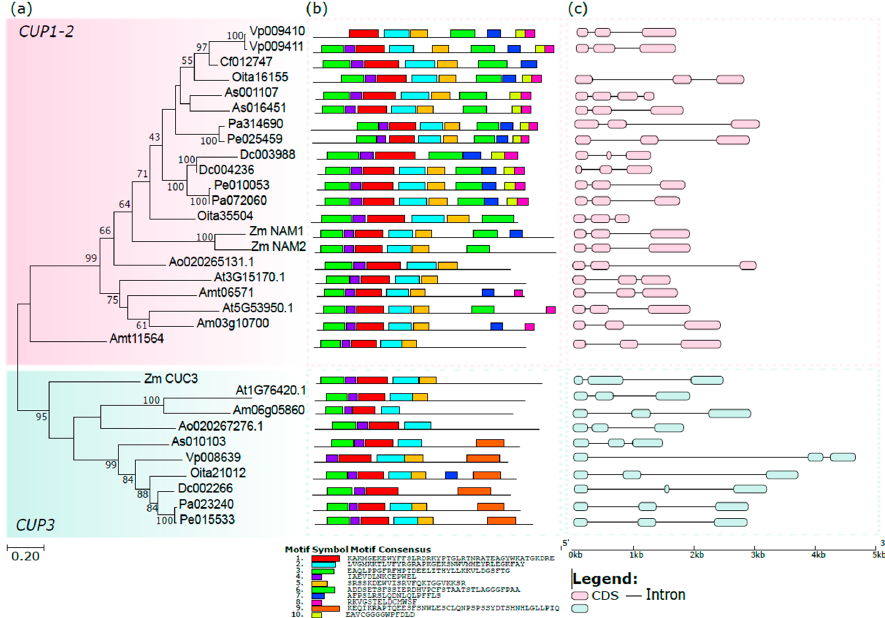
Figure 4. Phylogeny of orchid CUP proteins. ( a ) ML tree of the orchid CUP proteins, A. thaliana , A. majus , A. trichopoda , A. officinalis, and Z. mays ; ( b ) conserved motifs of CUP proteins (see Supplementary Material, Figure S1); ( c ) genomic organization of orchid CUP genes and other species with available